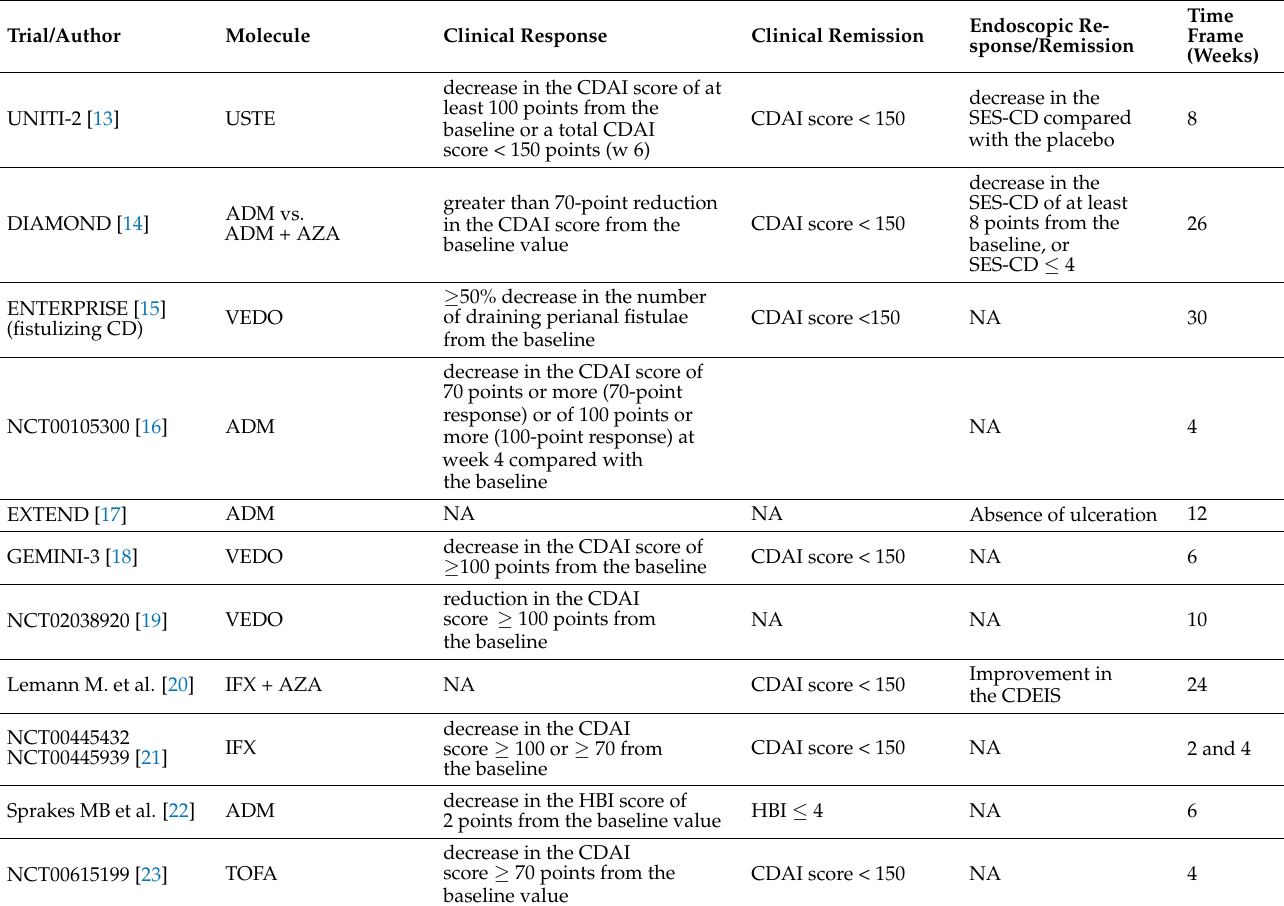
Table 2. Definitions of endpoints in Crohn’s disease clinical